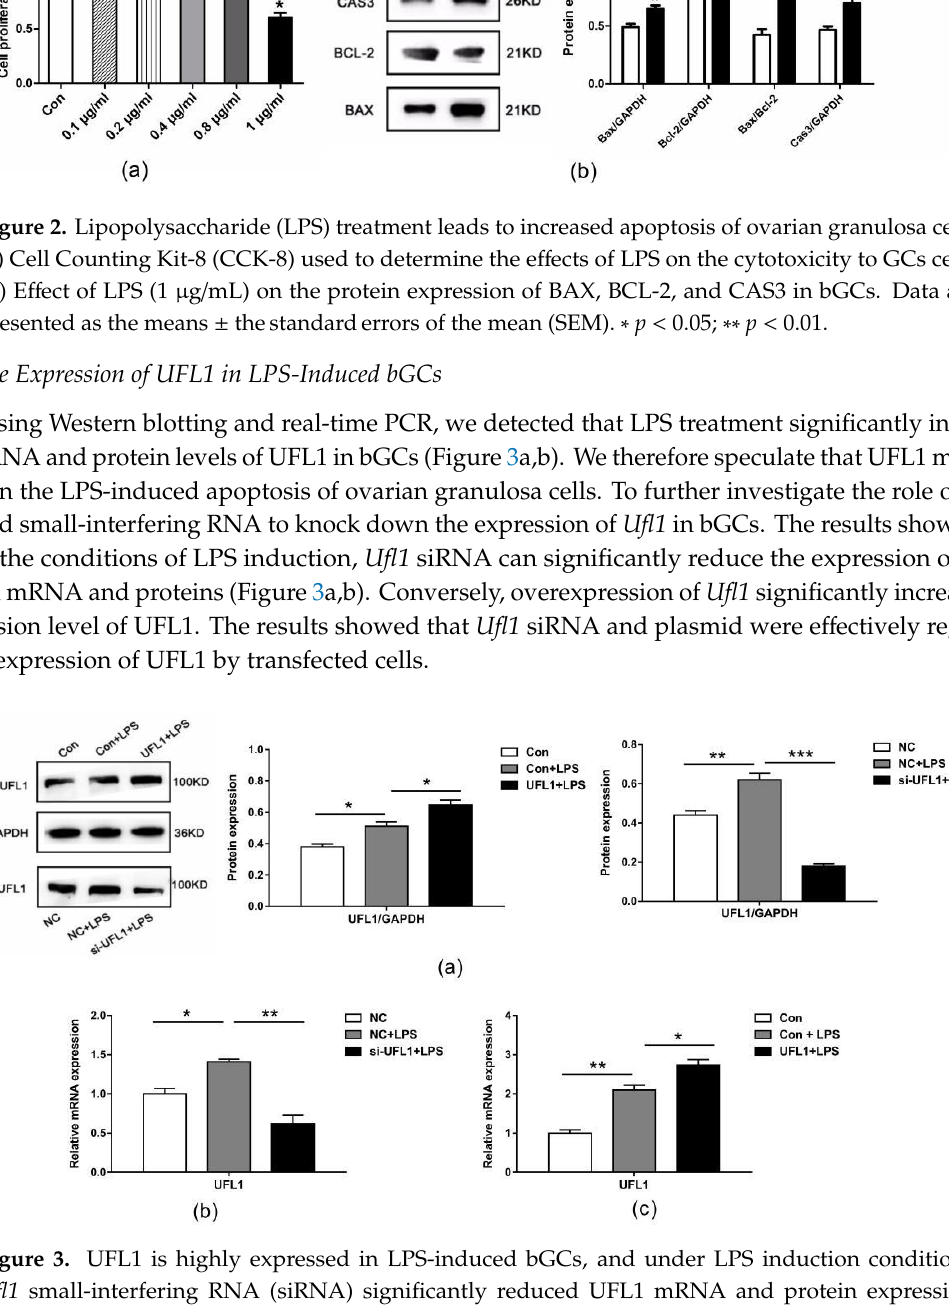
5 of 12 Figure 1. Ubiquitin-like modifier 1 ligating enzyme 1 (UFL1) is expressed in ovarian tissue and the cytoplasm and nucleus of granulosa cells. ( a ) More than 95% of the cells in the isolated cultured cells are ovarian granulosa cells. Identification of ovarian granulosa cells by immunofluorescence. ( b ) Immunofluorescent staining of bovine (ovarian) granulosa cells (bGCs) with anti-UFL1 antibody. ( c ) Bovine ovaries were analyzed by immunohistochemistry. 3.2. The Apoptosis Levels of bGCs under LPS Treatment